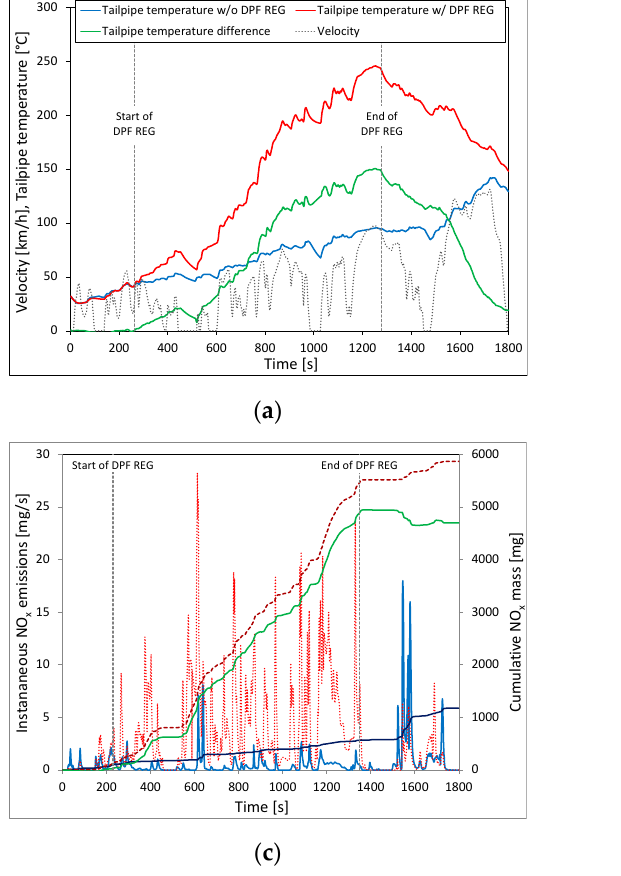
Figure 3. Indicative example of the identification of active DPF regeneration in WLTC testing. ( a ) Tailpipe temperature, ( b ) CO 2 emissions, ( c ) NO x emissions, ( d ) PN emissions (the case without DPF REG is hardly visible due to the very low PN levels).